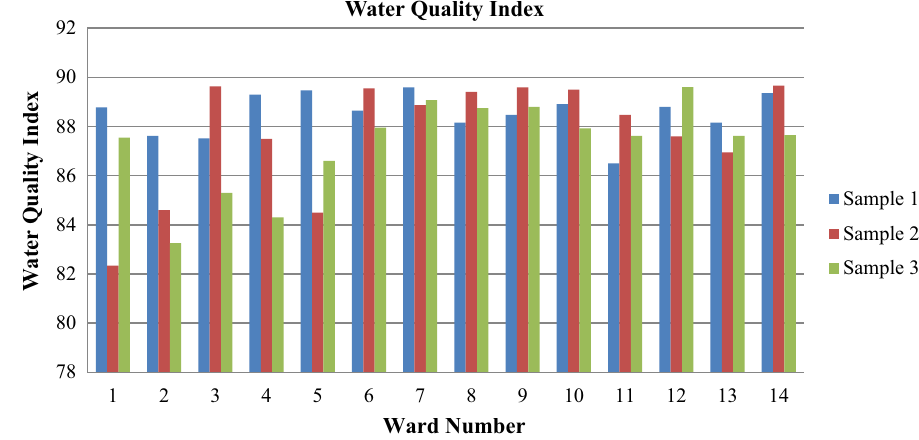
Fig. 9 Water quality